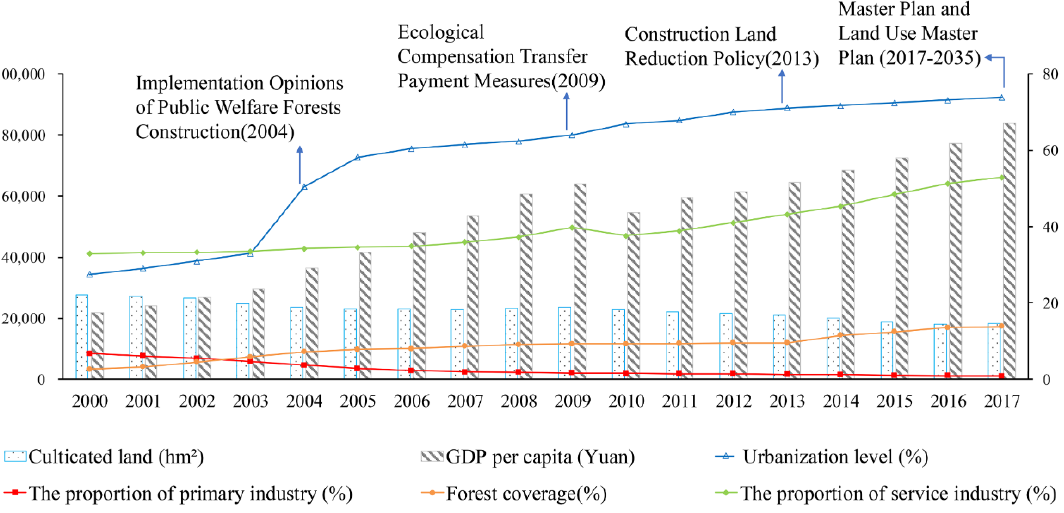
Figure 7. Summary of land policies and changing socioeconomic indicators in Qingpu District from 2000 to 2017.